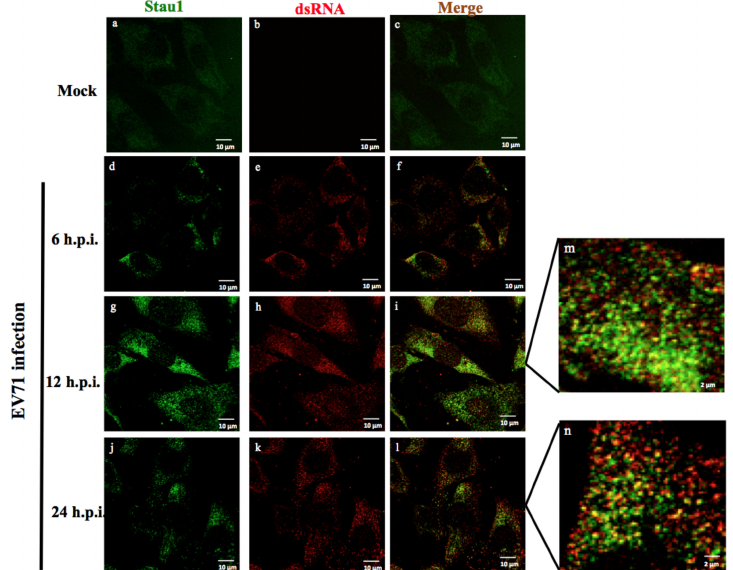
Figure 2. Colocalization of Stau1 with viral RNA in EV-A71-infected cells. RD cells were infected without or with EV-A71 at an MOI of 1 for 6, 12, and 24 h, followed by fixation and coimmunostaining with anti-Stau1 (green) and anti-dsRNA (red) antibodies. Bound primary antibodies were detected using secondary antibodies conjugated to Texas Red (for dsRNA) or fluorescein isothiocyanate (for Stau1). The images represent three independent experiments that used three independent infections. The merged images of anti-Stau1 (green) and anti-dsRNA (red) are shown in panels c, f, i and l, respectively. Panels m and n are enlarged images of panels i and l, respectively. Bar = 10 µ